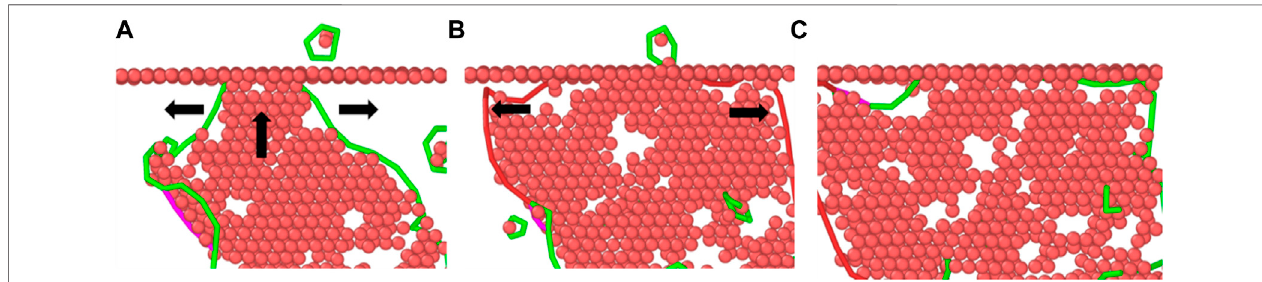
FIGURE 8 | Analysis snapshot of twin boundaries hindering the growth ofstacking faults. (A) SF grow along the shear direction. (B) SF change the grow direction. (C) The fi nal state of SF.